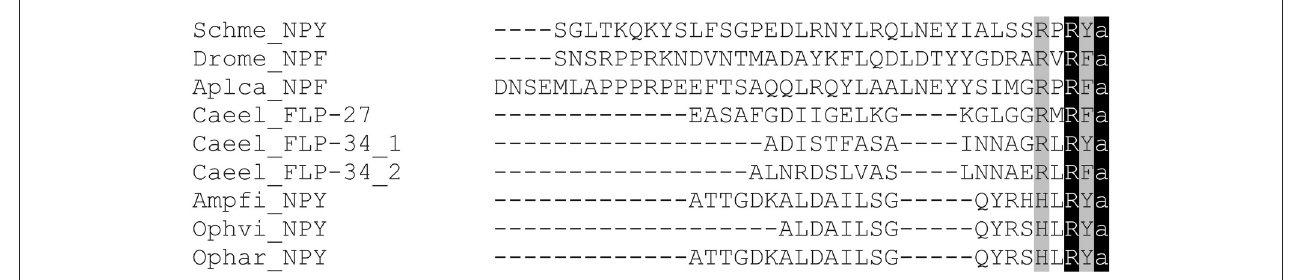
FIGURE 3 | Amino acid sequence alignment of representative NPFs from different invertebrate phyla. Genus and species abbreviations used in the alignment are: Schme, Schmidtea mediterranea; Drome, Drosophila melanogaster; Aplca , Aplysia californica; Caeel, Caenorhabditis elegans; Ampfi, Amphiura filiformis; Ophvi, Ophionotus victoriae; Ophar, Ophiopsila aranea . Identical residues are highlighted in black and conserved residues in